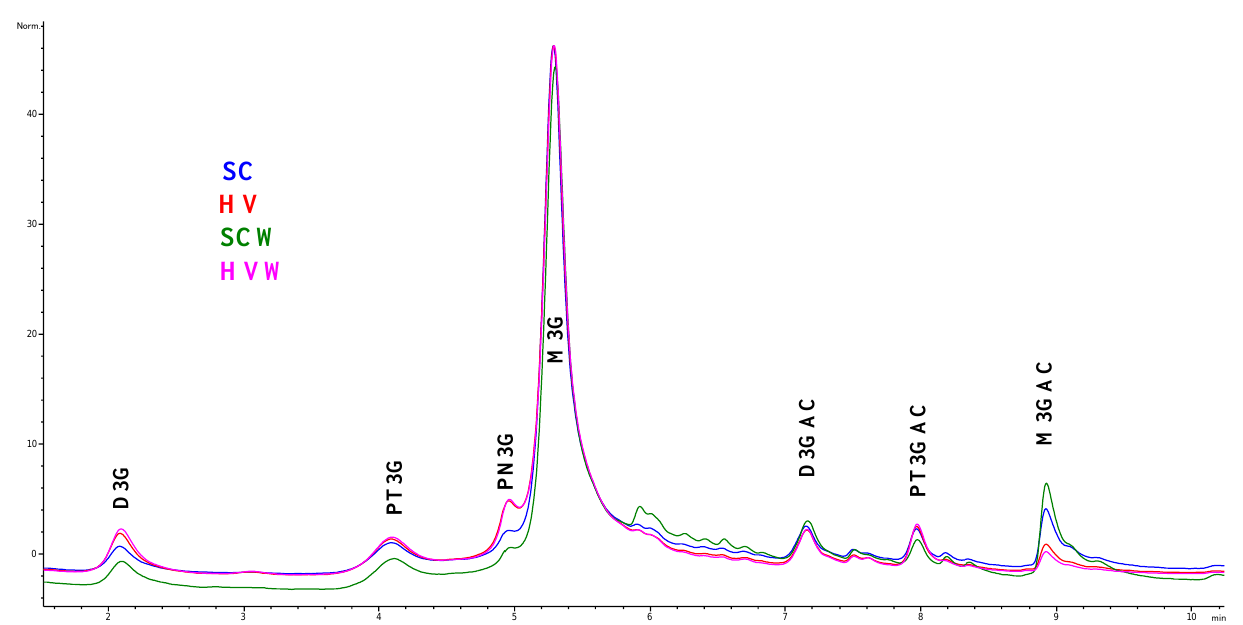
Figure 2. Chromatograms for anthocyanin identification by HPLC-DAD. SC (fermentations with S. cerevisiae in stainless steel barrels); HV (fermentations with H. vineae in stainless steel barrels); SCW (fermentations with S. cerevisiae in oak barrels); HVW (fermentations with H. vineae in oak barrels). Table 2. Anthocyanins content (mg/L) measured by HPLC-DAD.